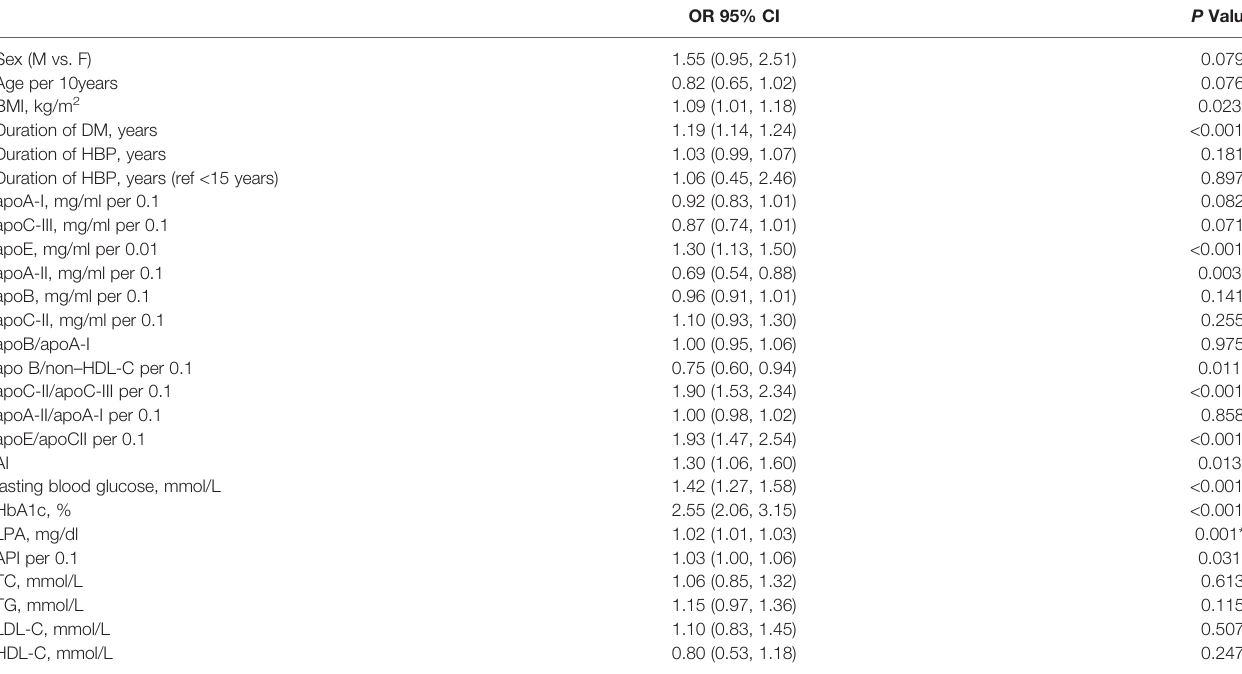
BMI, duration of DM, apoE, apoCII/CIII, apoE/CII, AI, API, fasting blood glucose, and HbA1c were signi fi cant independent risk factors for DR severity, but A-II and apoB/non – HDL-C were independent protective factor for DR occurrence and severity. *Statistically signi fi cant: p ≤ 0.05. **Statistically signi fi cant: p ≤ 0.001. DM, diabetes mellitus; apo, apolipoprotein; HbA1c, glycated hemoglobin; HDL-C, high-density lipoprotein cholesterol;LDL-C,low-densitylipoproteincholesterol;API/AI,atherogenicindexofplasma;API,atherogenicplasmaindex:de fi nedasLDL-C/HDL-C;AI,atherogenicindex:TC-(LDL-C)/ HDL-C; BMI, body mass index; TC, total cholesterol; TG, triglyceride; LPA, Lipoprotein